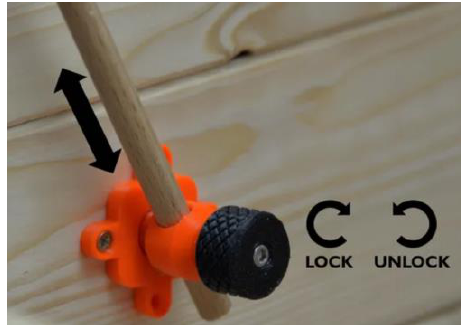
Figure 11. Open source adjustable window support [134].